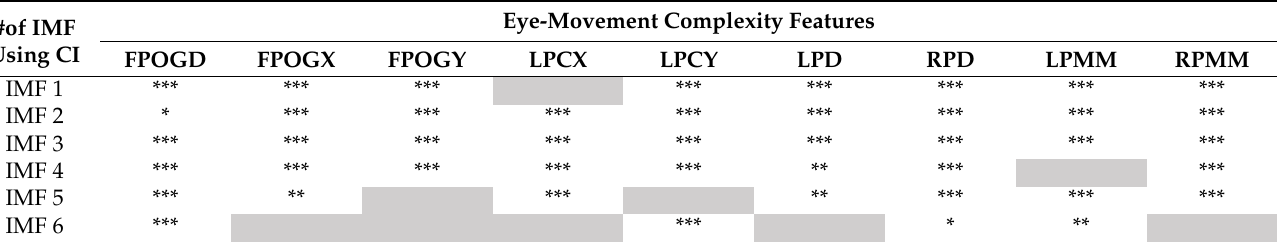
Table 3. Screened Eye-movement Complexity Features from CI of all